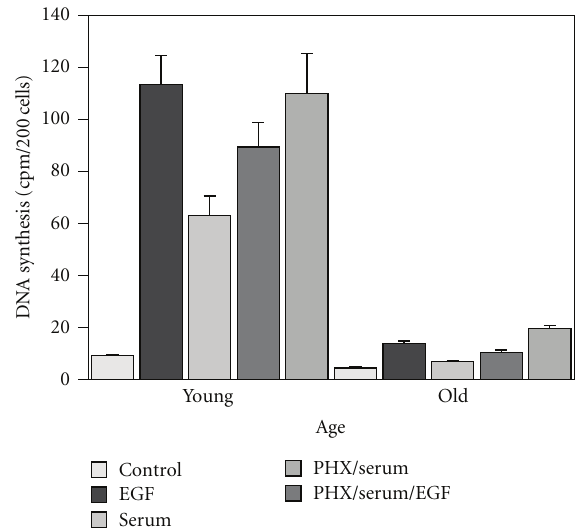
Figure 4: E ff ect of age on hepatocyte response to EGF and serum growth factors in young and old resting and posthepatectomy rats. Note that the posthepatectomy responses to both EGF (PHX) and EGF/serum were significantly greater in the young rats in comparison to their older cohorts. Data derived from